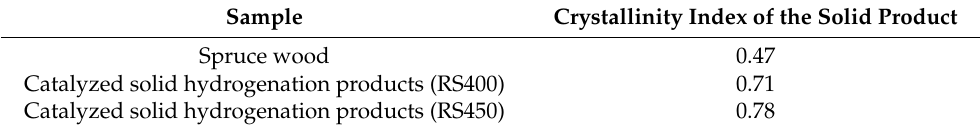
Table 10. Crystallinity indices for the spruce wood samples and solid products of wood RCF.